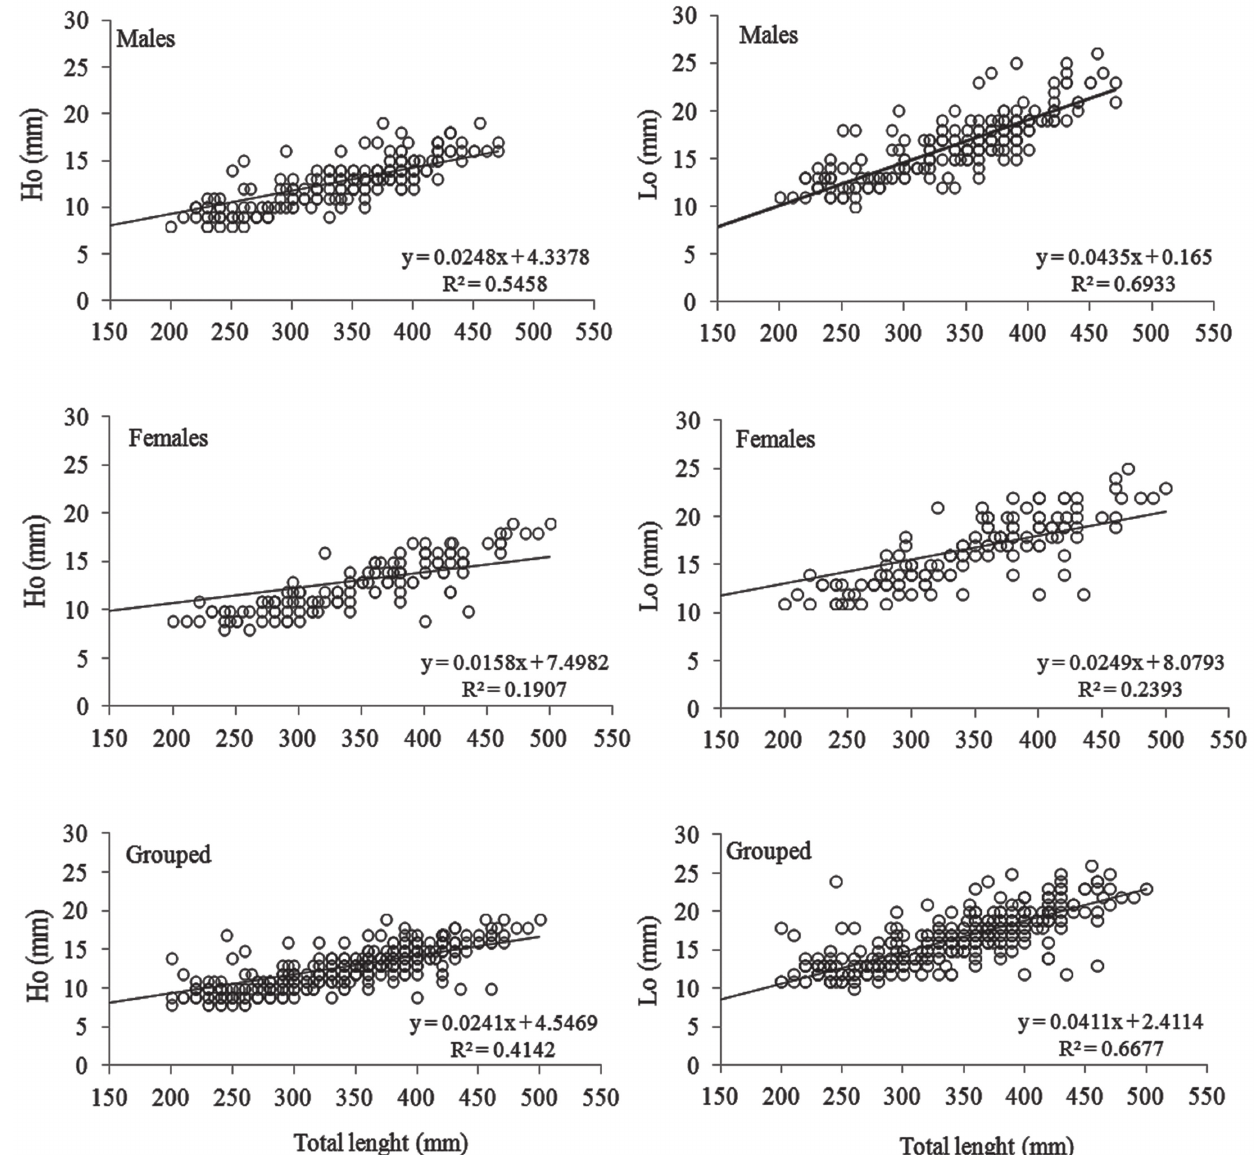
Fig. 3. Relative growth of otoliths parameters (Length and Height) against Total Length of Micropogonias furnieri